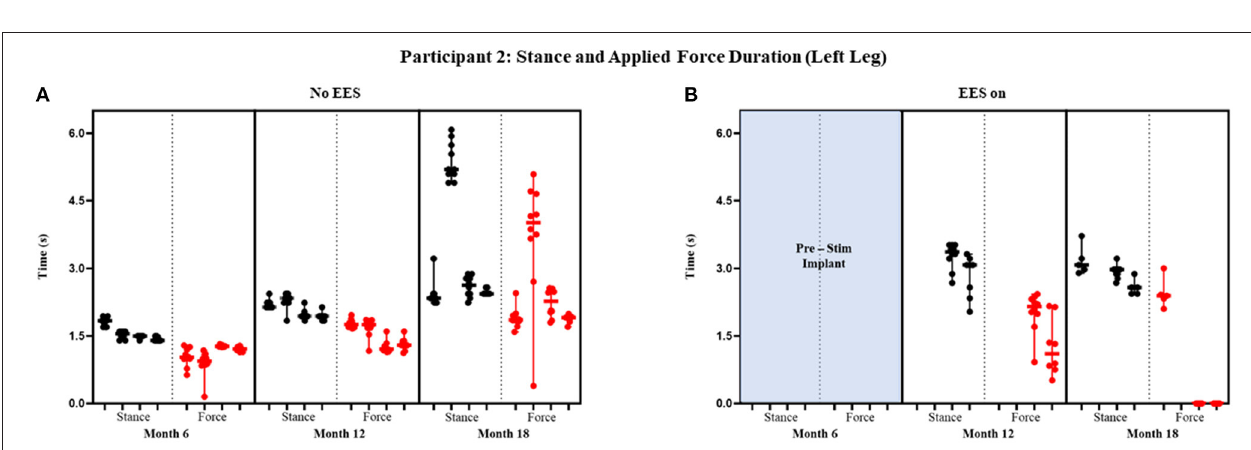
FIGURE 7 | Participant 2: stance and applied force duration left leg. Duration of stance (black dot) and applied force (red dot) with line at the median and range for left leg during no EES (A) and EES on (B) . Each tick in the x-axis represents a dataset of up to 10 consecutive cycles.